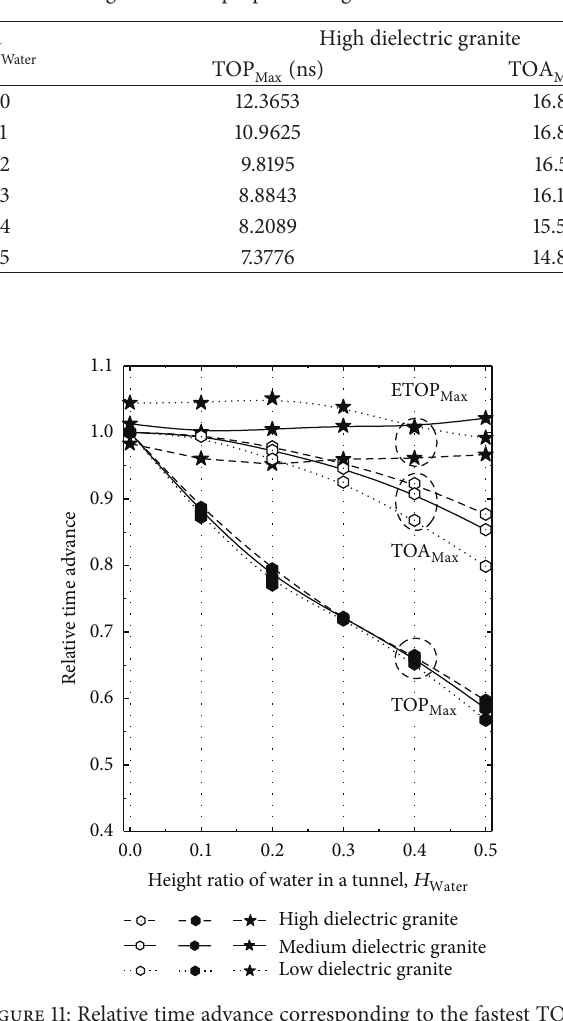
) by considering Water